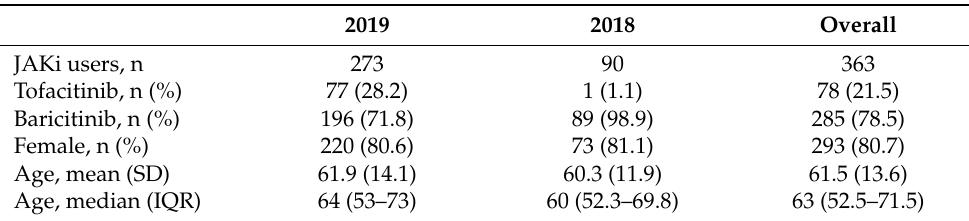
Table 1. Incident JAKi users’ characteristics, overall and stratified by the years of the cohort entry (first analysis).